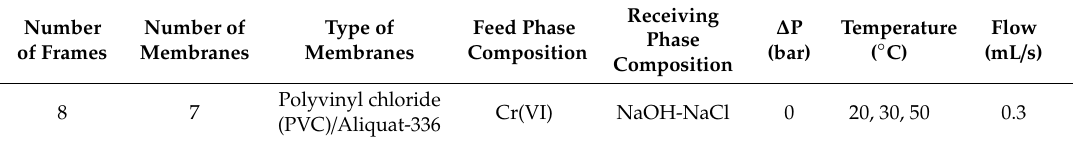
Table 1. Experimental